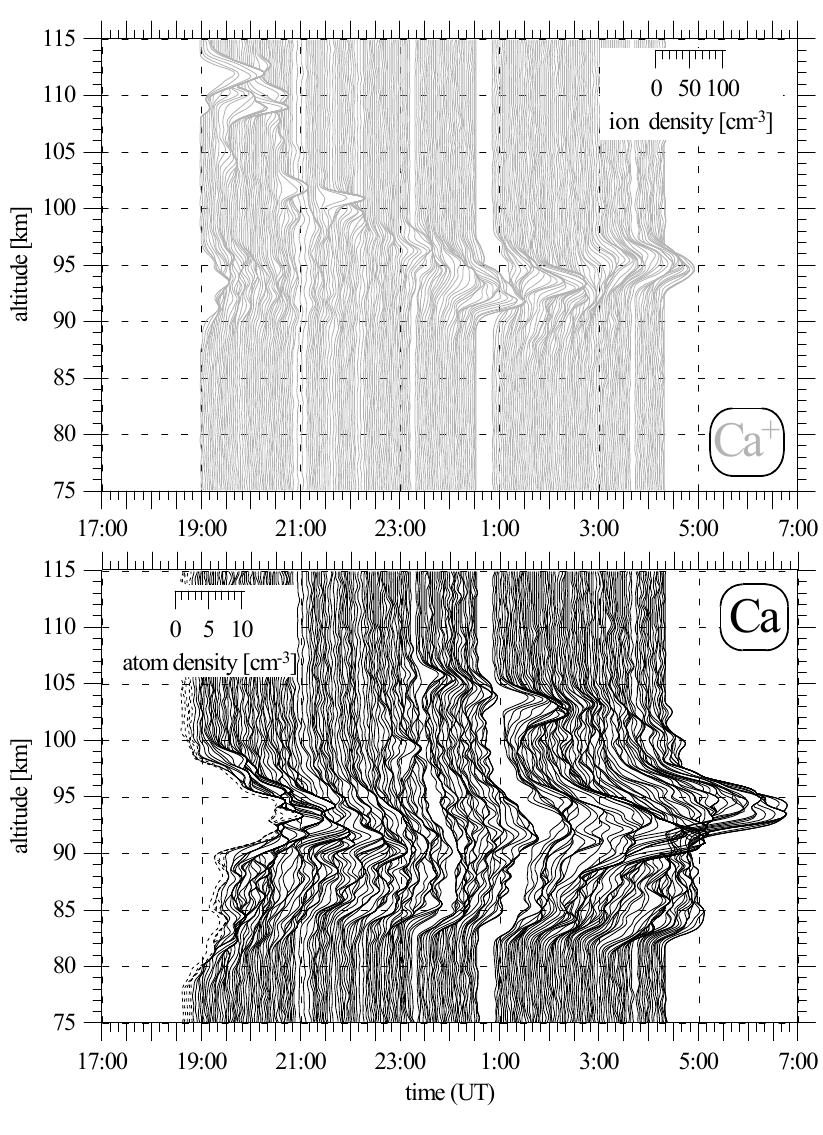
Fig. 5. Series of density profiles ob- tained during the night March 4/5, 1997 for Ca + (upper panel) and Ca (lower panel). Various simultaneous and sin- gle Ca + or Ca sporadic layers are visi- ble and will be identified in the